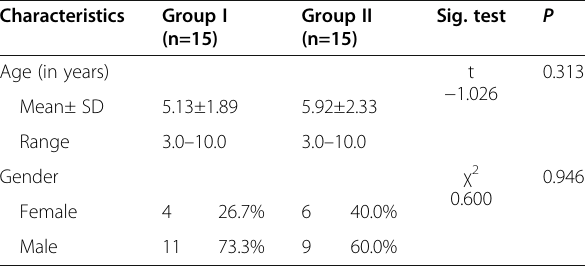
Table 1 Sociodemographic data for patients enrolled in the study